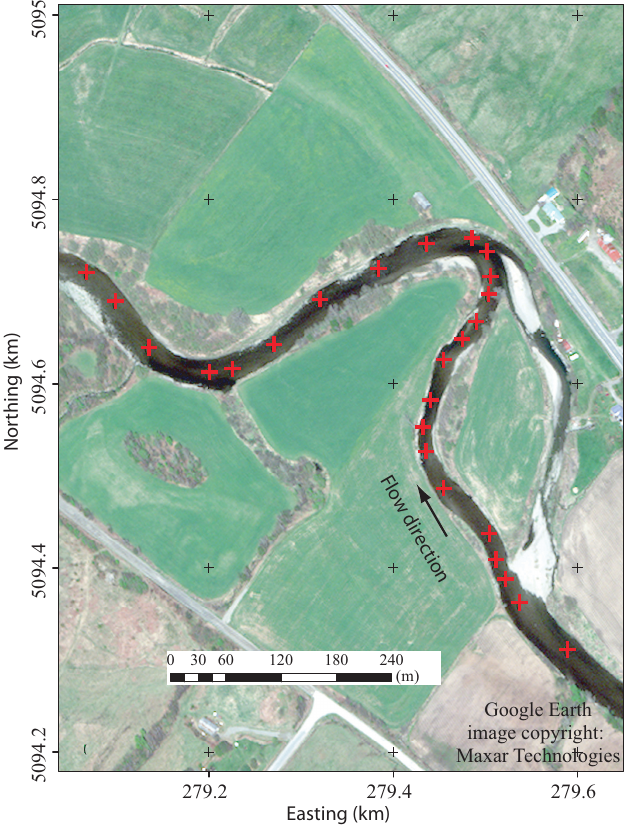
Figure 5. The ground coordinates of pixels in Figure 4 translated some units to the west and to the north until the river path from the WV-3 image matched the red plus